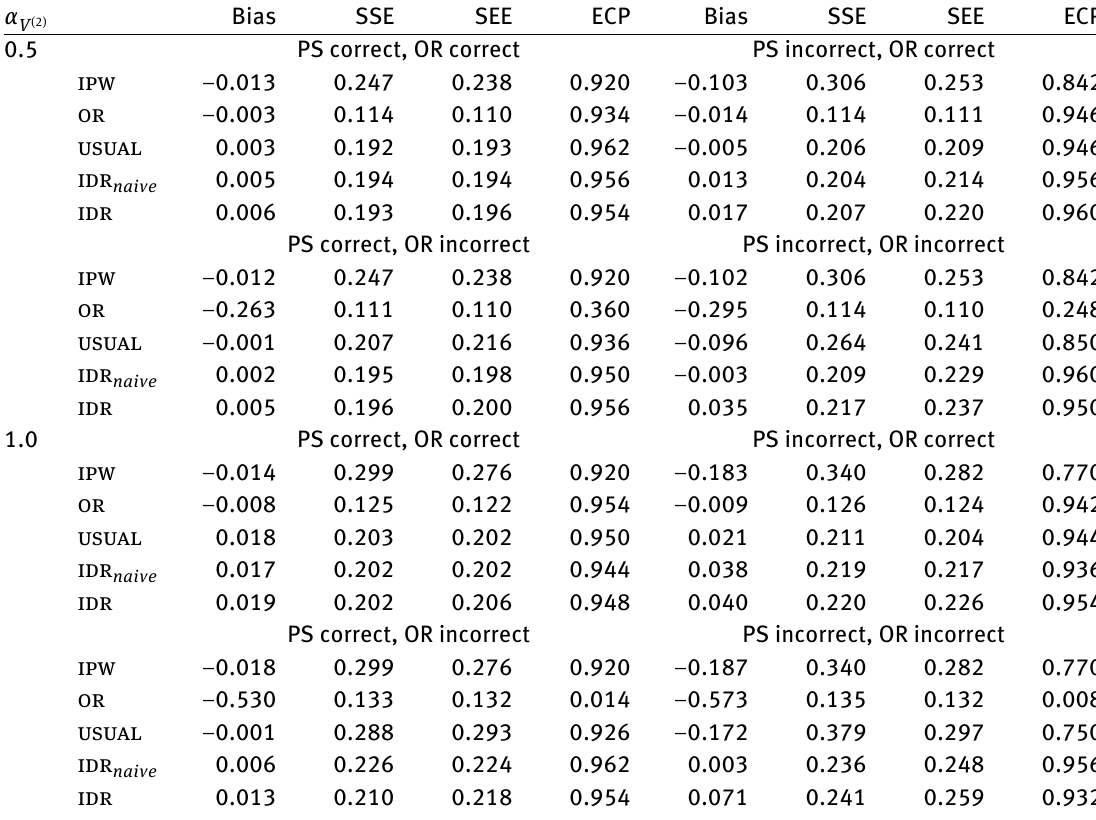
Table 2: Simulation results for estimating the mean potential outcome in a dynamic treatment regime. Table entries include Monte Carlo bias, simulation standard error (SSE), standard error estimate (SEE), and empirical coverage probability (ECP) for a 95% confidence